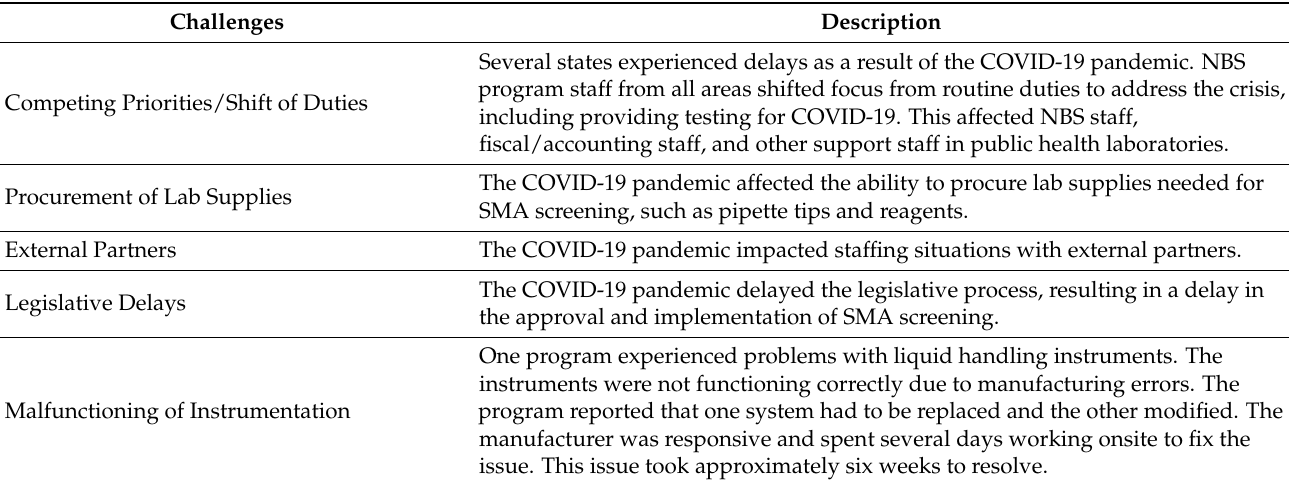
Table 5. Challenges reported by state newborn screening programs receiving NewSTEPs funding to implement SMA newborn screening coinciding with the 2020 global COVID-19 pandemic.